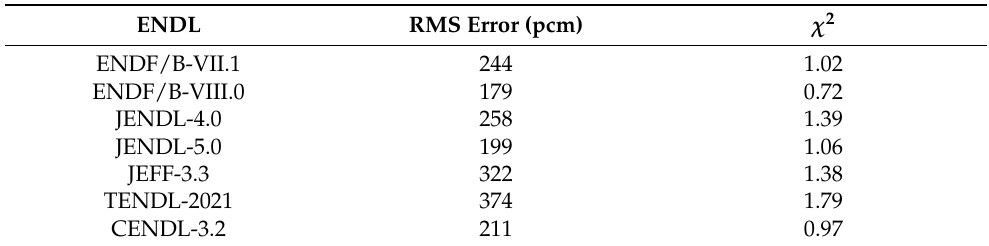
Table 4. RMS errors and chi square values of the 31 fast benchmarks for different evaluated nuclear data